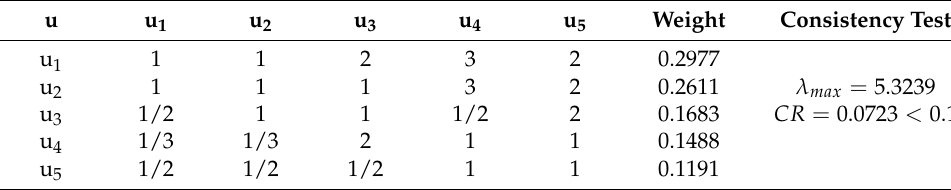
Table 13. The judgment matrix and weights of evaluation indicators under